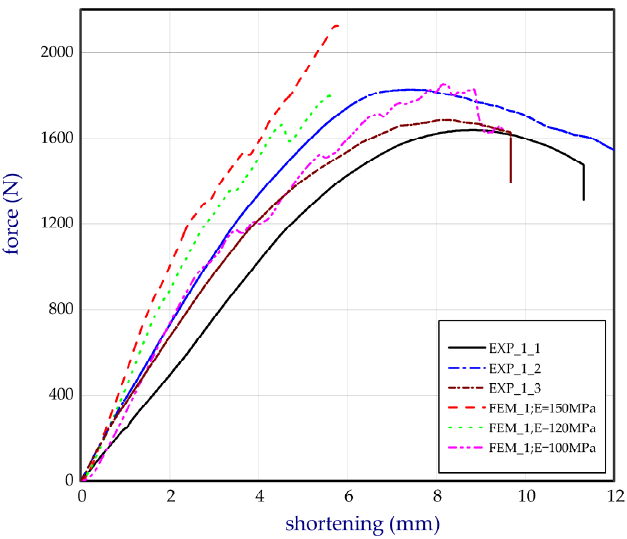
Figure 11. Total force of compression in a function of shortening for the basic model.